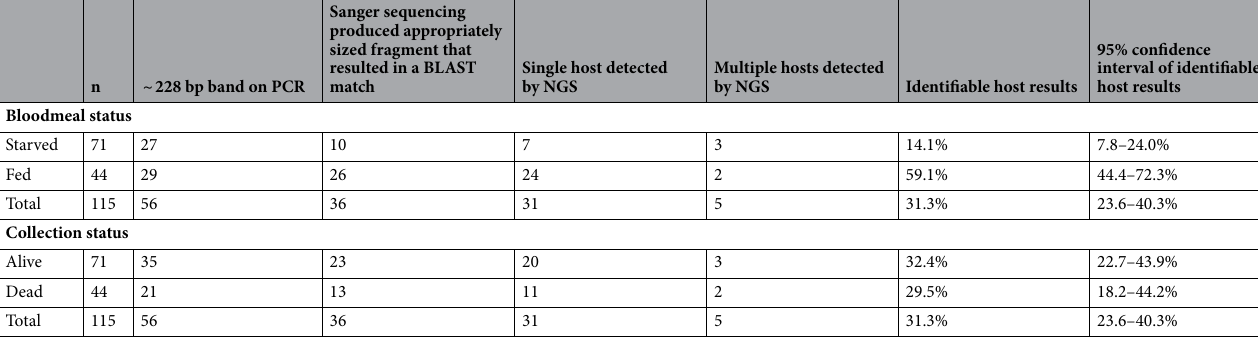
Table 1. Triatomine bloodmeal scores, number of samples with hosts identified, and detection of multiple bloodmeal hosts via next generation sequencing. During dissection, triatomines were assigned bloodmeal scores of 1 (no blood, desiccated guts), 2 (no blood, guts visible), 3 (traces of blood in gut), 4 (blood present, but either not much or not fresh [dried]), or 5 (large amount of fresh blood); these were then classified as ‘starved’ (scores of 1–3) or fed (scores of 4 or 5). The herp1/herp1 primer set was used to amplify a 228 bp fragment of DNA (some samples also produced a second band of ~ 450 bp). Sanger sequencing and BLAST matching were used to determine bloodmeal hosts. Triatomines of ‘fed’ statuses more frequently had a bloodmeal host characterized via Sanger sequencing that triatomines of ‘starved’ statuses. In addition to